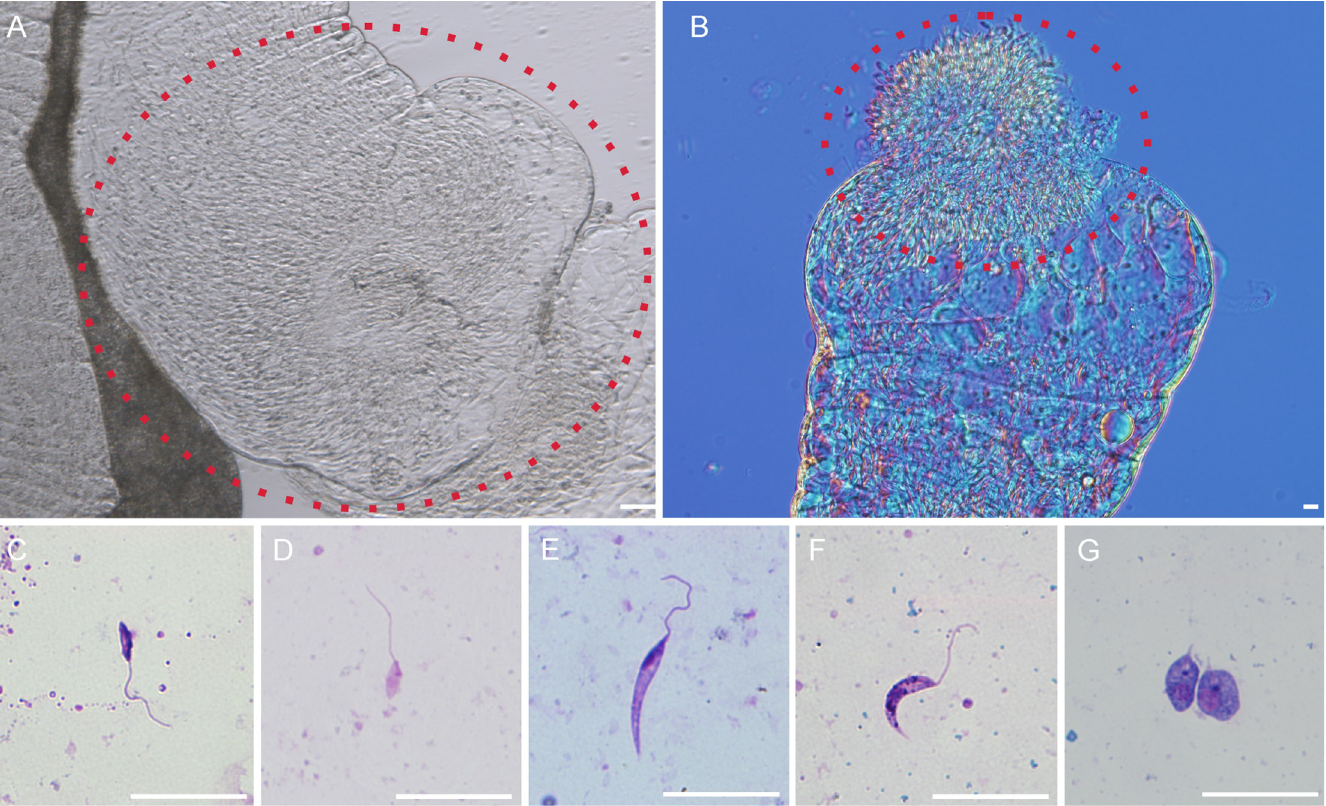
Fig 6. Localisation and morphology of Mundinia in biting midge C . sonorensis on day 10 PBM. A-B, colonization of the stomodeal valve with the part of the thoracic midgut filled with parasites, the region is marked by a red dotted line: (A) mature infection with L . martiniquensis Cu1; (B) mature infection with L . orientalis . C-G, various morphological forms present in the midgut on day 10 PBM: (C) metacyclic form of L . martiniquensis Cu2; (D) metacyclic form of L . orientalis ; (E) nectomonad form of L . martiniquensis MAR1; (F) leptomonad form of L . martiniquensis Cu2; (G) haptomonad form of L . martiniquensis Cu2. Scale bar = 20 μ m. https://doi.org/10.1371/journal.ppat.1009654.g006 Table 1. Comparison of intensities of late infections between C . sonorensis and sand fly species. Leishmania sp. Vector sp.